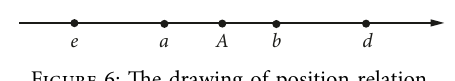
Figure 6: The drawing of position